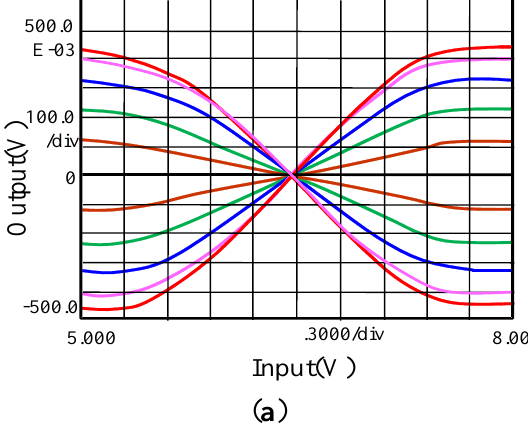
Figure 11. Synaptic multiplication with ( a ) Gilbert multiplier-based circuit [10,16]; ( b ) memristor based